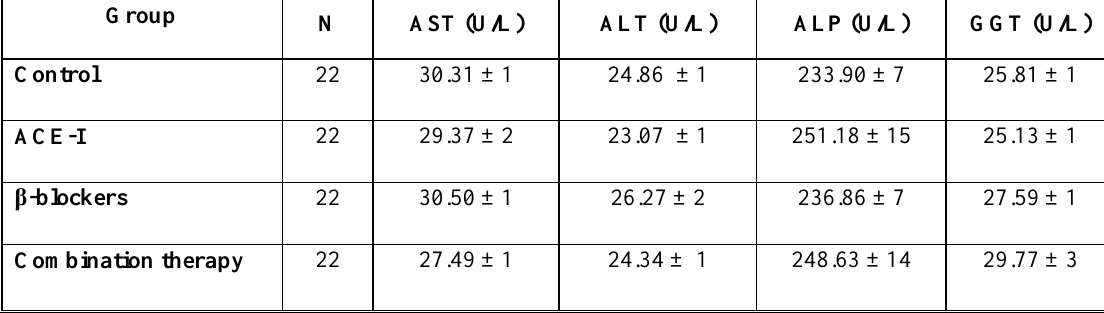
Table 6: Serum AST, ALT, ALP and GGT in control healthy individuals and hypertensive patients treated with different antihypertensive drug regimens. Each value represents mean± standard error of mean